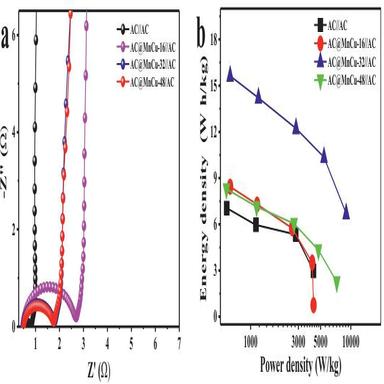
(a) Nyquist plot and (b) Ragone plot of symmetric and asymmetric capacitors.